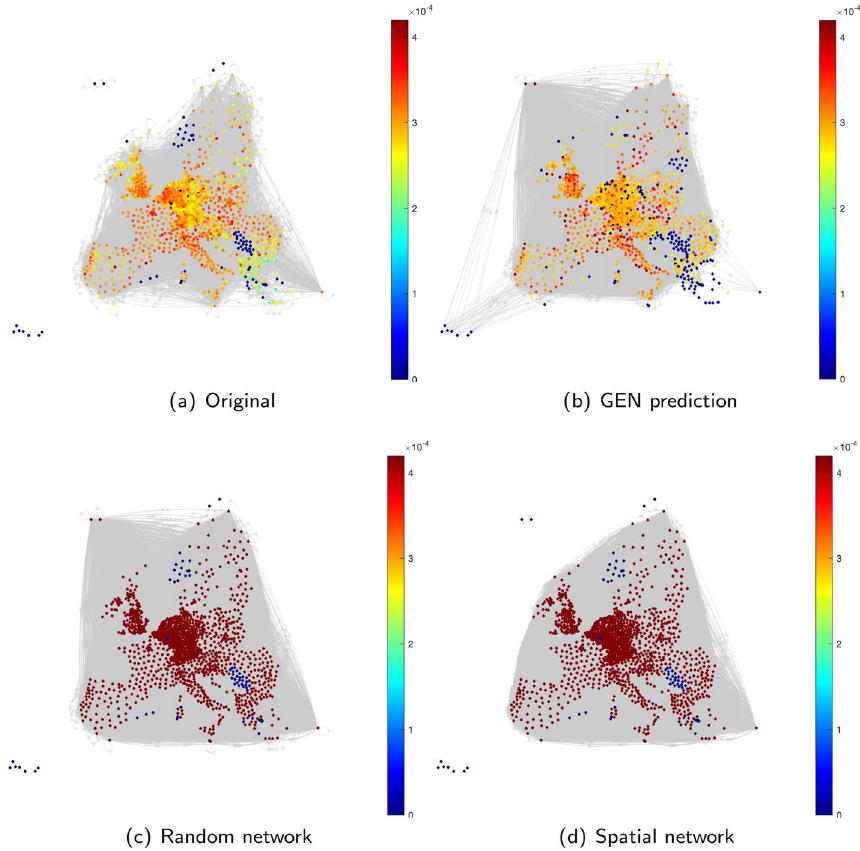
Fig. 4 Predicted network structures and their in-closeness centralities